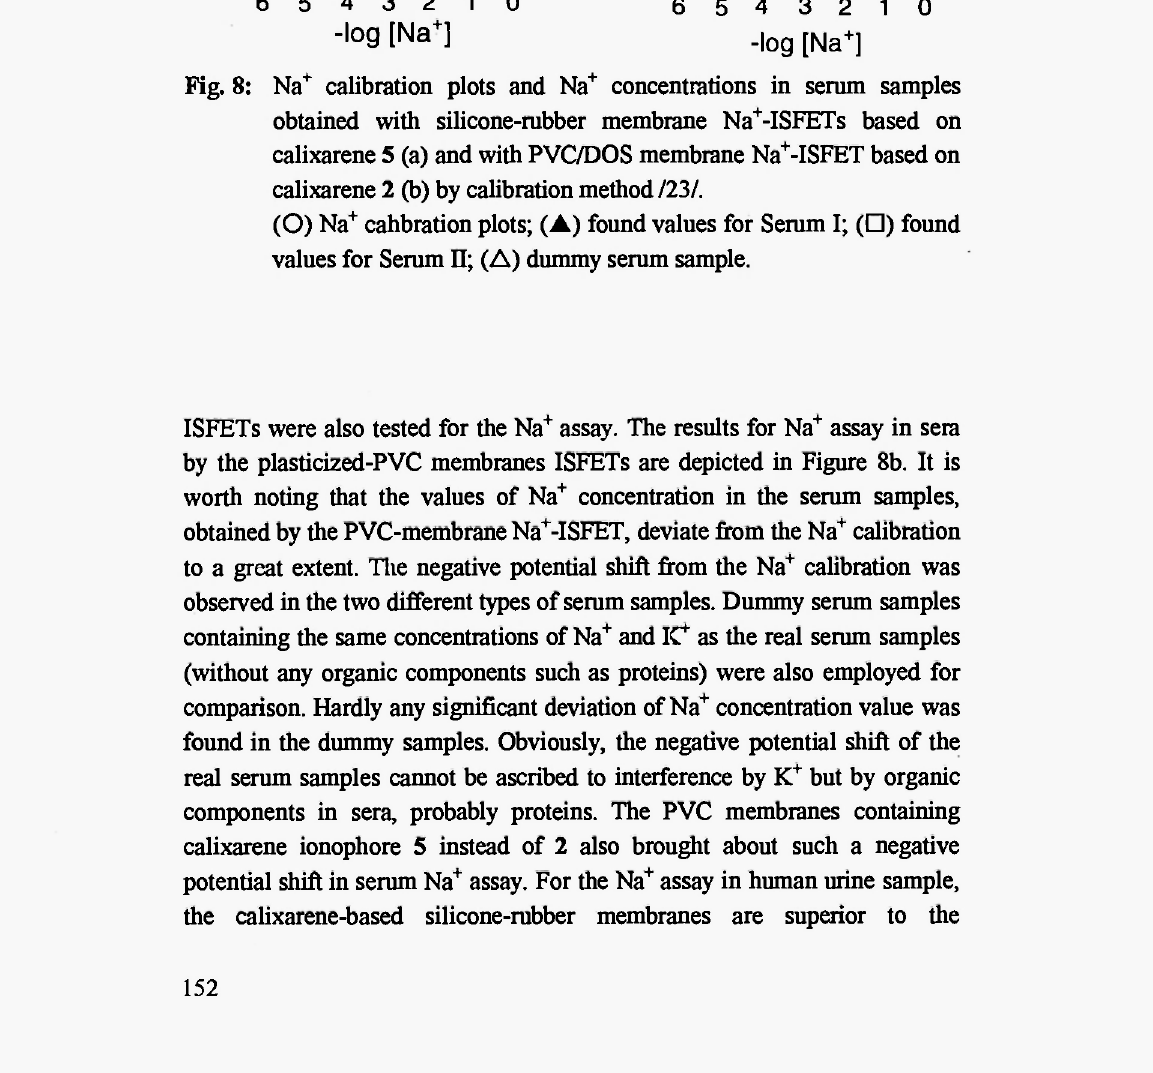
Fig. 8: Na + calibration plots and Na + concentrations in serum samples obtained with silicone-rubber membrane Na + -ISFETs based on calixarene 5 (a) and with PVC/DOS membrane Na + -ISFET based on calixarene 2 (b) by calibration method